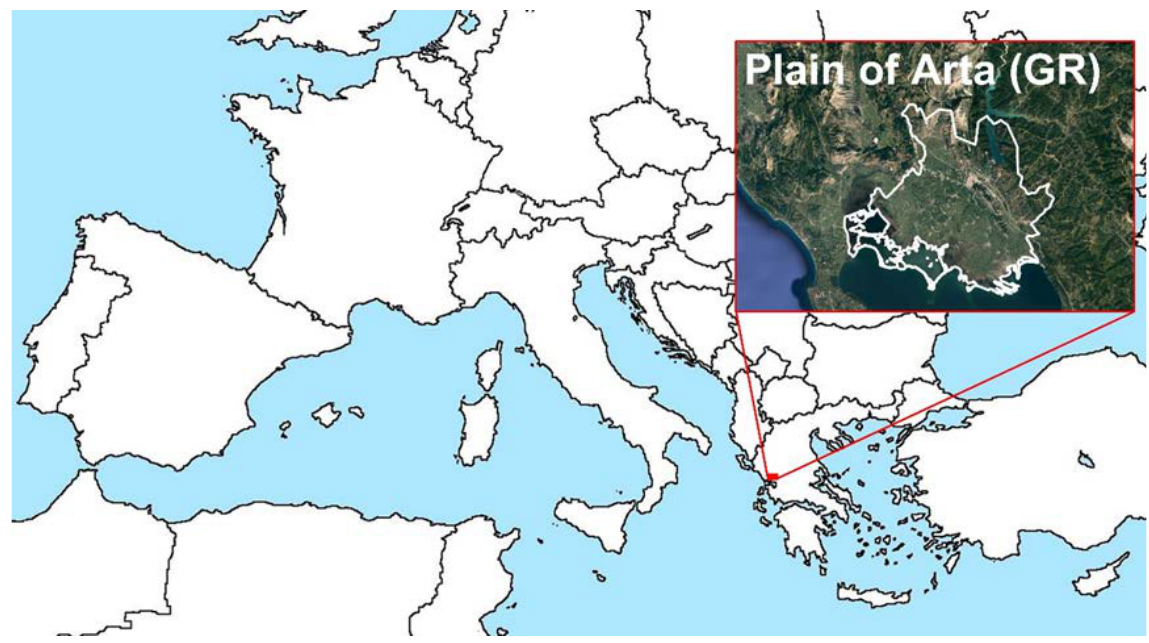
Figure 1. Map of Greece, Epirus region, and plain of Arta (green spot) in northwestern Greece. The prevailing crops in the plain consist of citrus, olive, and kiwifruit trees, along with some arable crops. Olive is one of the most important crops in terms of surface area at a regional level, with about 5500 ha of cultivated land, of which 30% is irrigated [5]. The area of table olive groves that are registered for Common Agricultural Policy (CAP) subsidies occupy almost 3200 ha [31]. The average planting density is 250 trees per ha. The main inputs during the olive life cycle are energy (electricity and fuel) consumption, water consumption, and the use of chemical products (pesticides and fertilizers). Fertilization is carried out early in the year (January–March) in both rainfed and irrigated